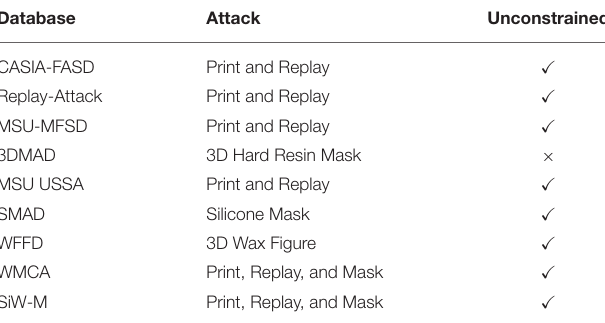
TABLE 5 | Video and frame based EER ( µ ± σ )% on the proposed NIR print attack database. Ethnicity